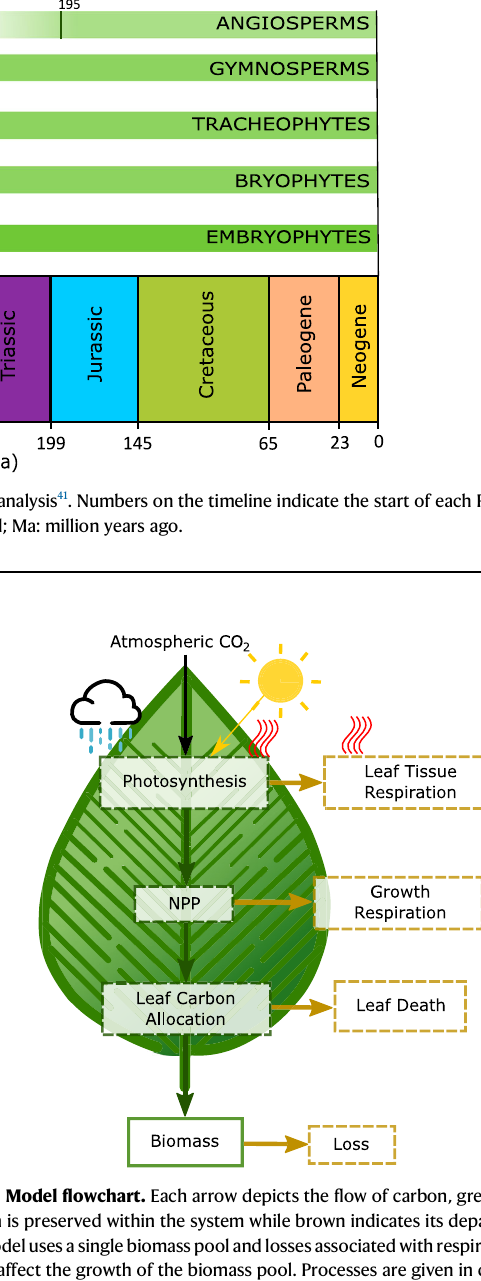
Fig. 2 | Model fl owchart. Each arrow depicts the fl ow of carbon, green indicates carbon is preserved within the system while brown indicates its departure. Note: themodelusesasinglebiomasspoolandlossesassociatedwithrespirationandleaf death affect the growth of the biomass pool. Processes are given in dashed boxes whereas reservoirs are presented in bold boxes. Processes that are affected by temperature(redlines),insolation(arrowfromsun)andwaterstress(bluerain)are indicated. NPP: net primary